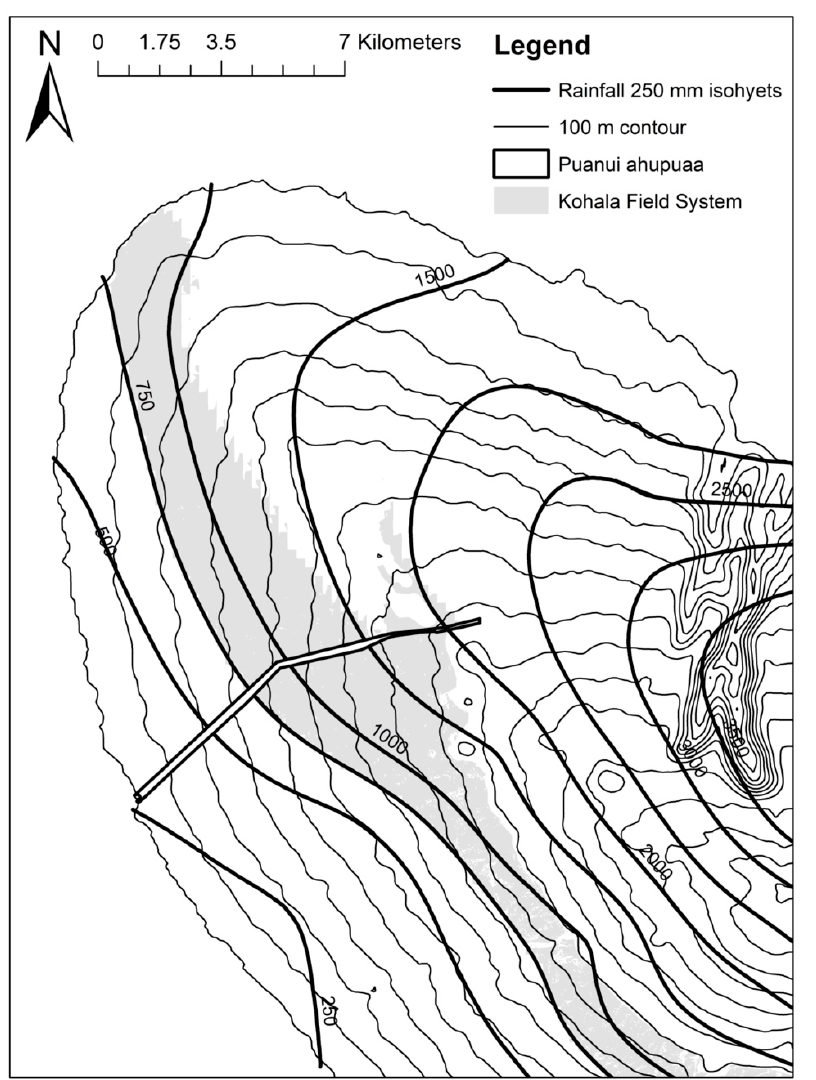
Figure 1. Map of the study area, depicting the landscape, the modeled extent of the Leeward Kohala Field System, and the ahupua’a of Puanui.